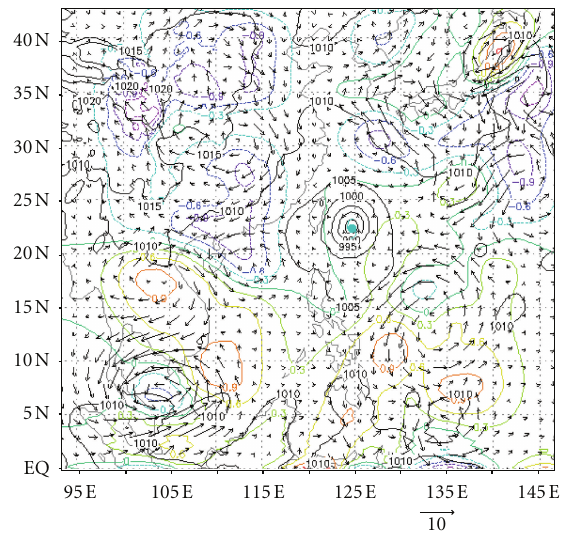
Figure 7: The modifications in the velocity and temperature fields in the initial condition due to assimilation of AIRS data. Shown is the case for the run initialized at 18UTC, 11 September 2008, with LEN SCALING = 0.5 and VAR SCALING = 0.2. The vectors are the di ff erence (defined as the outcome of a run with AIRS data minus that of the control run without AIRS) in the velocity at 500 hPa. Color contours are the di ff erence in temperature, and black contours are the sea level pressure of the control run. The blue filled circle indicates the center of